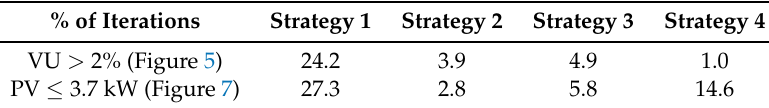
Table 2. Comparison of Monte Carlo simulation and Maximum PV Injection.